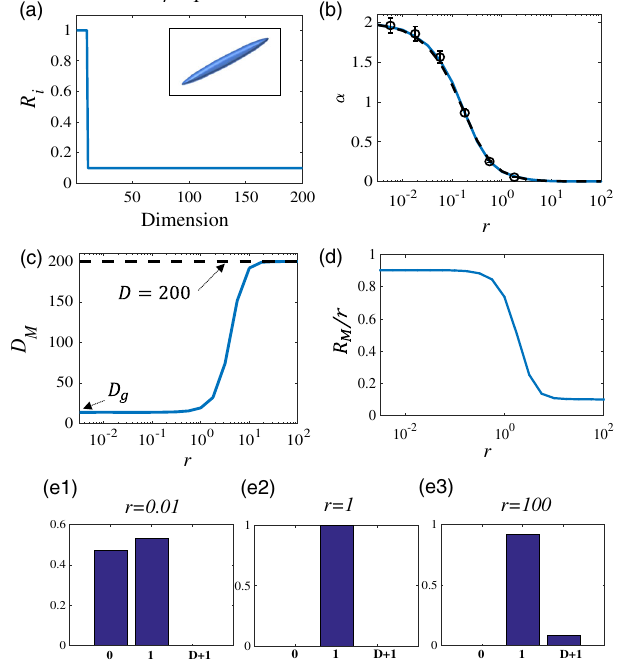
FIG. 7. Bimodal l 2 ellipsoids. (a) Ellipsoidal radii R with i r ¼ 1 . (b) Classification capacity as a function of scaling factor r : full mean-field theory capacity (blue lines); approximation of the capacity given by equivalent ball with R and D (black dashed M M lines); simulation capacity (circles), averaged over five repeti- tions, measured with 50 dichotomies per repetition. (c) Manifold dimension D as a function of r . (d) Manifold radius R relative M M to r . (e) Fraction of manifolds with support dimension k for different values of r : k ¼ 0 (interior), k ¼ 1 (touching), k ¼ D þ 1 (fully supporting). (e1) Small r ¼ 0 . 01 , where most manifolds are interior or touching. (e2) r ¼ 1 , where most manifolds are in the touching regime. (e3) r ¼ 100 , where the fraction of fully supporting manifolds is 0.085, predicted by p ffiffiffiffiffiffiffiffiffiffiffiffiffiffiP H ð − t H ð R − 2 Þ [Eq. fs Þ ¼ i i